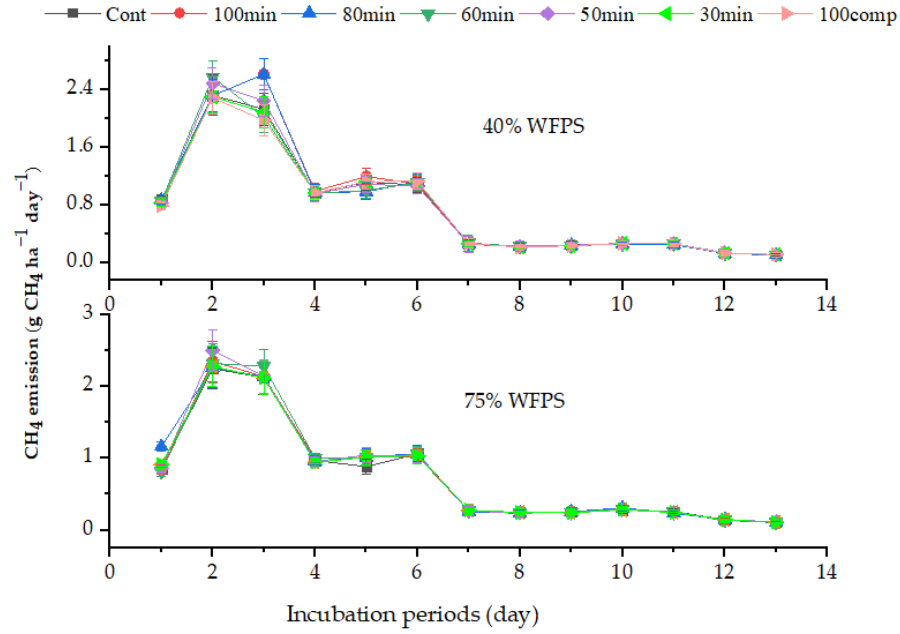
Figure 5. Emissions of methane (CH 4 -C) from treatments with different fertilizer types and water filled pore-space (WFPS) (40% and 75%). Cont.: Cont.: Control (no input); 100 min: 100% mineral fertilizer N (100 kg N ha − 1 ) and P (33.3 kg P ha − 1 ), 80 min: 80% mineral fertilizer + 1.4 t ha − 1 compost; 60 min: 60% mineral fertilizer + 2.8 t ha − 1 compost; 50 min: 50% mineral fertilizer + 3.5 t ha − 1 compost; 30 min: 30% mineral fertilizer + 4.9 t ha − 1 compost, and 100comp: 100% compost (7 t ha − 1 compost). Error bars indicate the standard error of the mean (n =